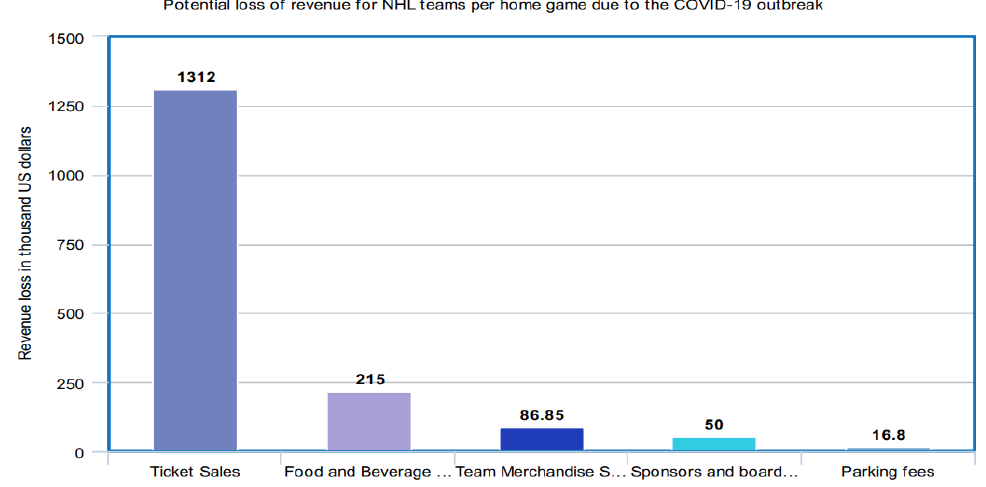
Figure 16. Potential loss of revenue for National Hockey League (NHL) teams per home game due to the COVID-19 outbreak